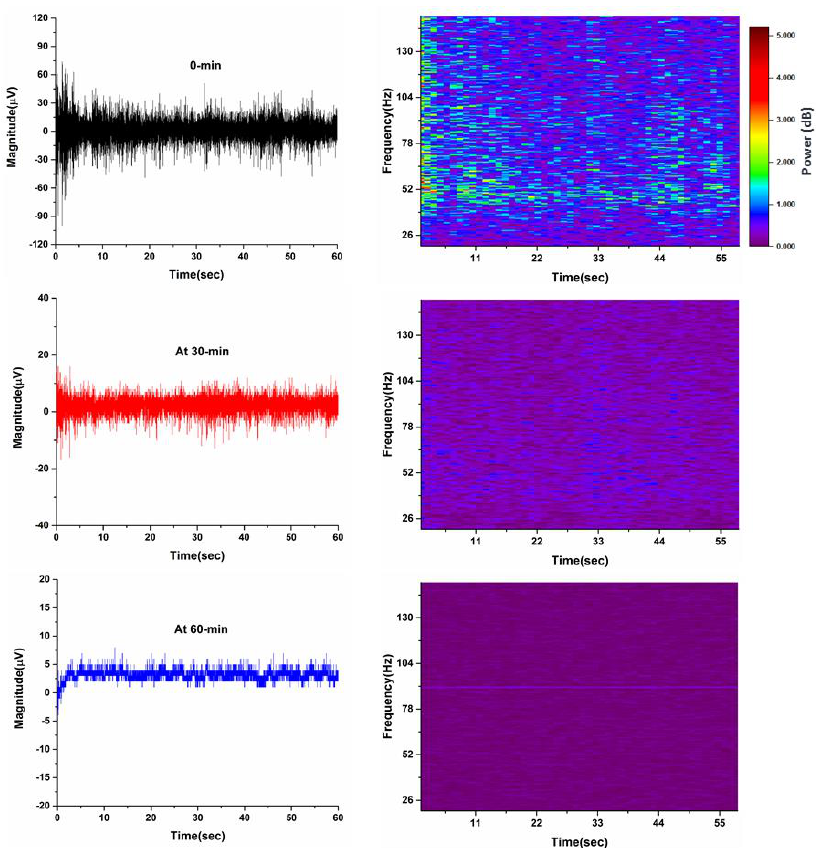
Figure 7. Raw EMG signals with different amplitudes at various times and their respective spectro- grams. The color bar shows the magnitude of the frequency over time.